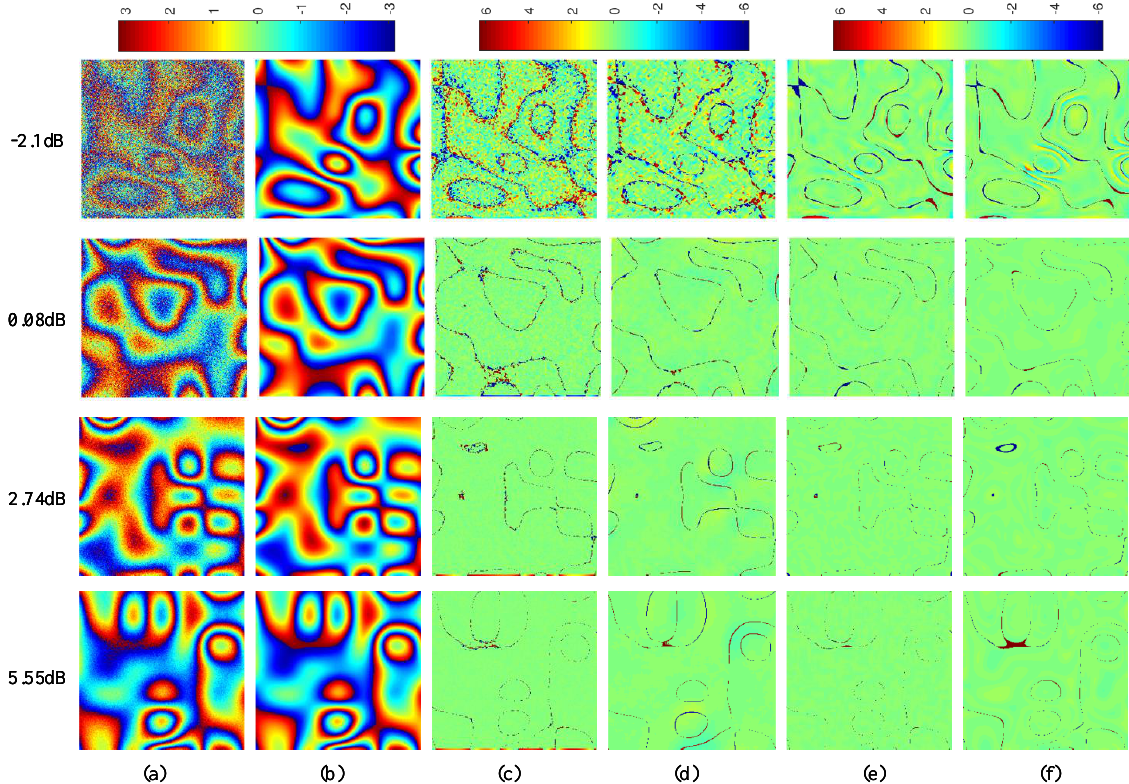
Figure 14. Filtered results of four methods for images with different values of SNR. ( a ) Noisy interferometric phase. ( b ) Clean interferometric phase. ( c ) Phase difference of the Lee filter. ( d ) Phase difference of the Goldstein filter. ( e ) Phase difference of the InSAR-BM3D filter. ( f ) Phase difference of the proposed